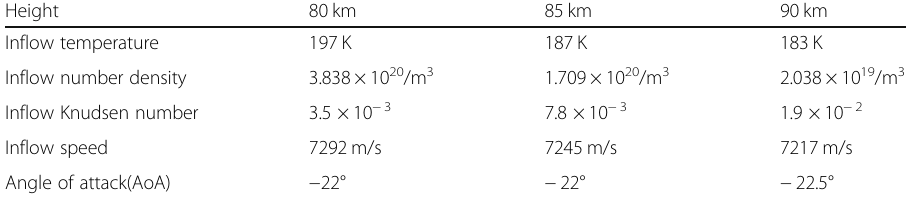
Table 7 Typical related parameters of the lunar exploration type capsule for the first jump-out Height 80 km 85 km 90 km Inflow temperature 197 K 187 K 183 K Inflow number density 3.838 × 10 20 /m 3 1.709 × 10 20 /m 3 2.038 × 10 19 /m 3 Inflow Knudsen number 3.5 × 10 − 3 7.8 × 10 − 3 1.9 × 10 − 2 Inflow speed 7292 m/s 7245 m/s 7217 m/s Angle of attack(AoA) − 22° − 22° −